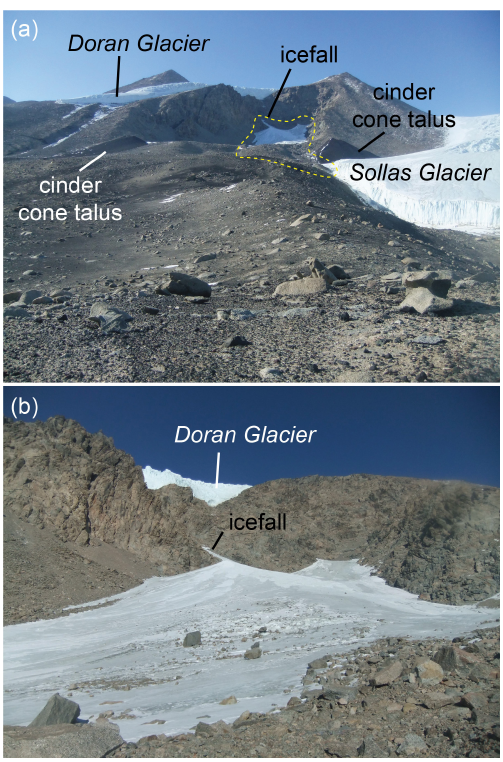
Figure 3. Icefall originating from Doran Glacier and accumulating to form the rock glacier. (a) View from base of Sollas Glacier, with rock glacier visible within yellow dashed line. Note presence of cinder cone talus slopes. (b) View from boundary between debris- covered ice and the modern exposed